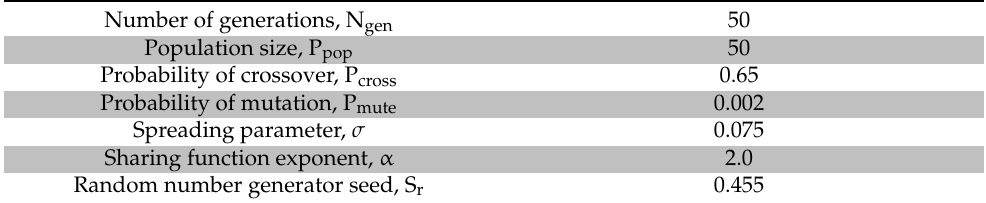
Table 2. Numerical parameter values used in NSGA